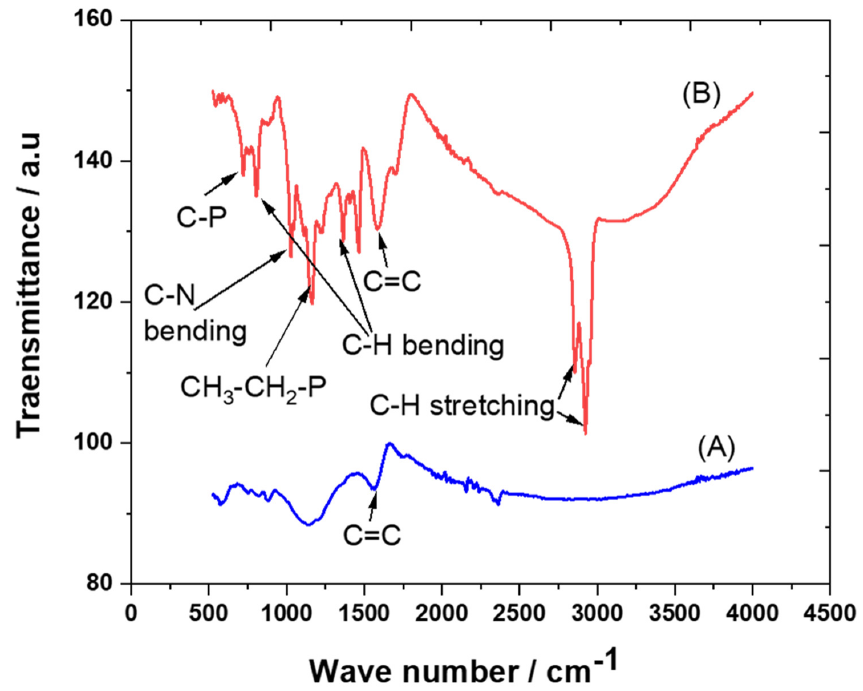
Figure 2. FTIR spectra of carbon ( A ) and trihexYl(tetradecyl)phosphonium dicyanamide-modified renewable carbon ( B ).